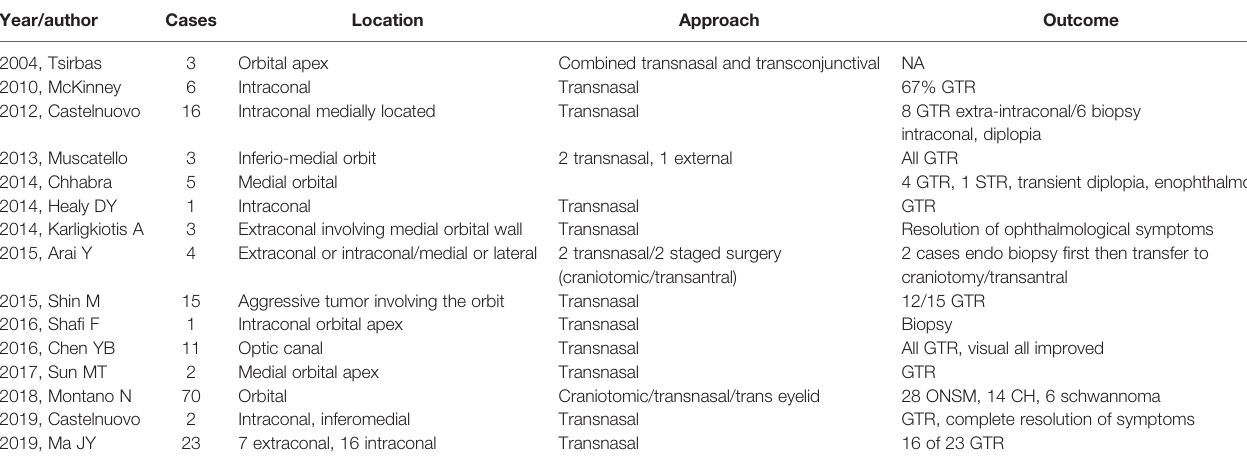
TABLE 2 | Literature review of the intraorbital tumors using purely endoscopic transnasal approach.